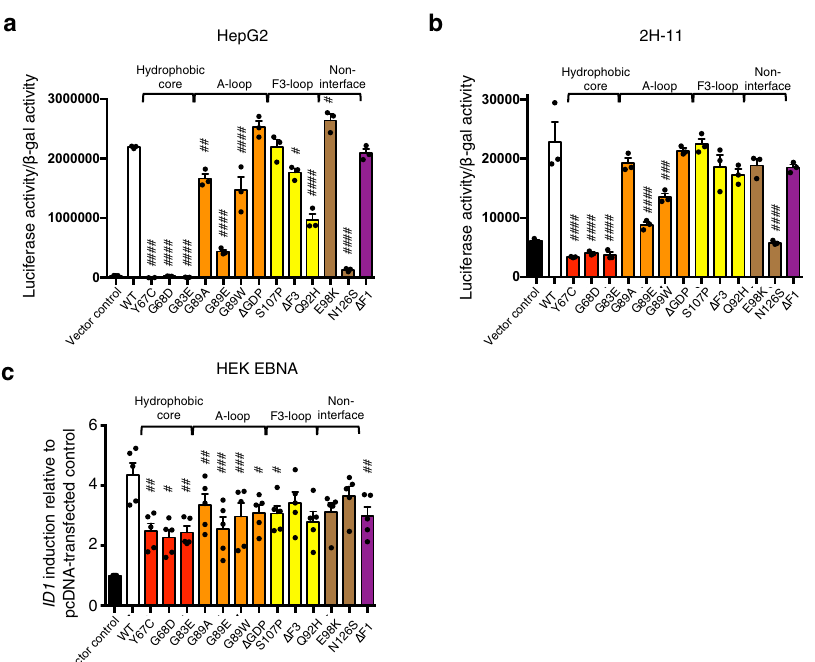
Fig. 9 BMPR2 mutations that disrupt BMP10 binding also result in impaired BMPRII-mediated signalling. BMPRII-mediated signalling assay was established by transfecting cells with pcDEF plasmids containing short form of BMPR2 WT or mutant sequences. a , b HepG2 ( a ) and 2H-11 ( b ) cells were seeded in 24-well plates and transfected with BRE-luc reporter, β -gal plasmid (transfection control) and mutant or WT BMPR2 plasmids in triplicate. 48 h post-transfection, the cells were serum-starved overnight before luciferase activity was measured. c HEK-EBNA cells were seeded in 6 well plates and transfected with the same set of BMPR2 plasmids over 24-hour duration before harvesting for RNA and qPCR analysis of ID1 gene expression. Gene expression level is presented as fold-change relative to B2M and further normalised to control (transfected with vector only). N = 5, with each N number represents an independent transfection and signalling experiment. For a – c , means ± SEM are shown, data were analysed using One-way ANOVA with Dunnett ’ s post test for comparing with WT transfection. # P < 0.05, ## P < 0.01, ### P < 0.001, #### P < 0.0001. Source data, including the exact p values, are provided as a Source Data fi le. Colour scheme and abbreviations are the same as in Fig.